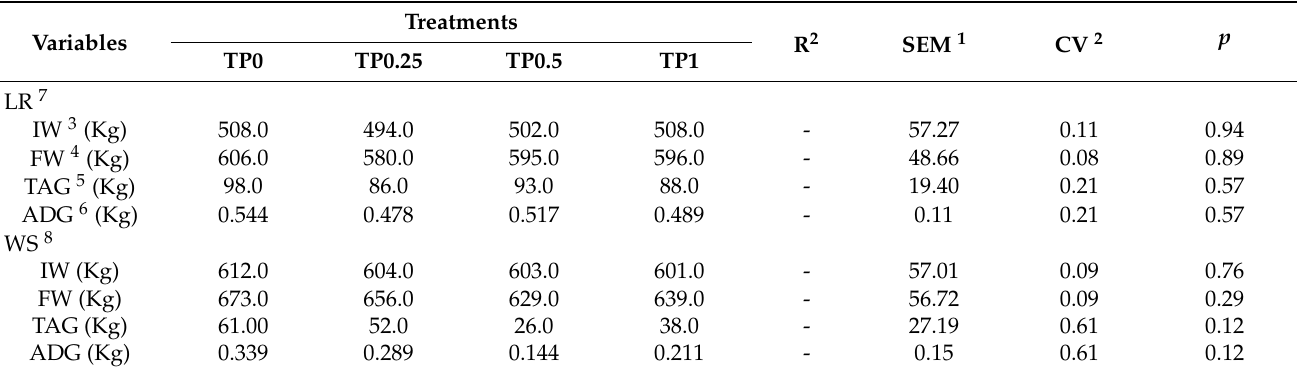
Table 9. Performance of female buffaloes under intermittent grazing of Marandu grass supplemented with different levels of palm kernel